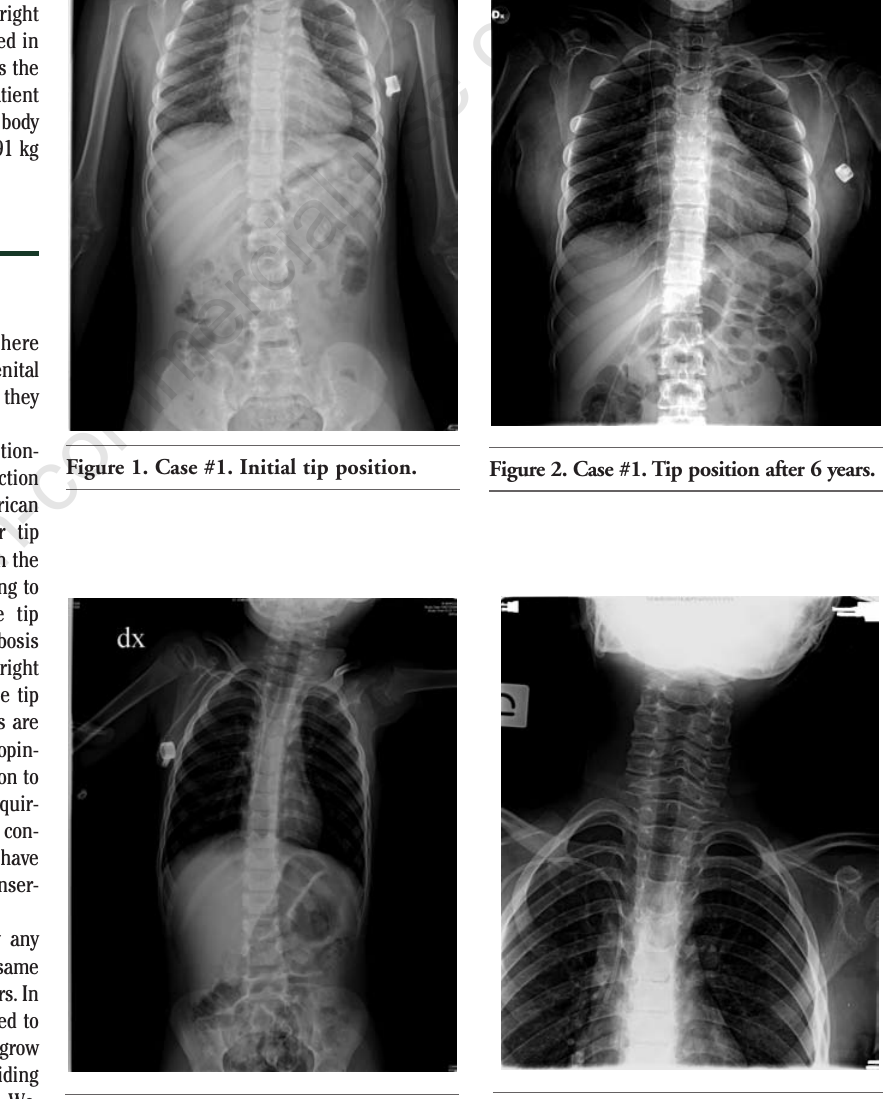
Figure 3. Case #2. Initial tip position. Figure 4. Case #2. Tip position after 6